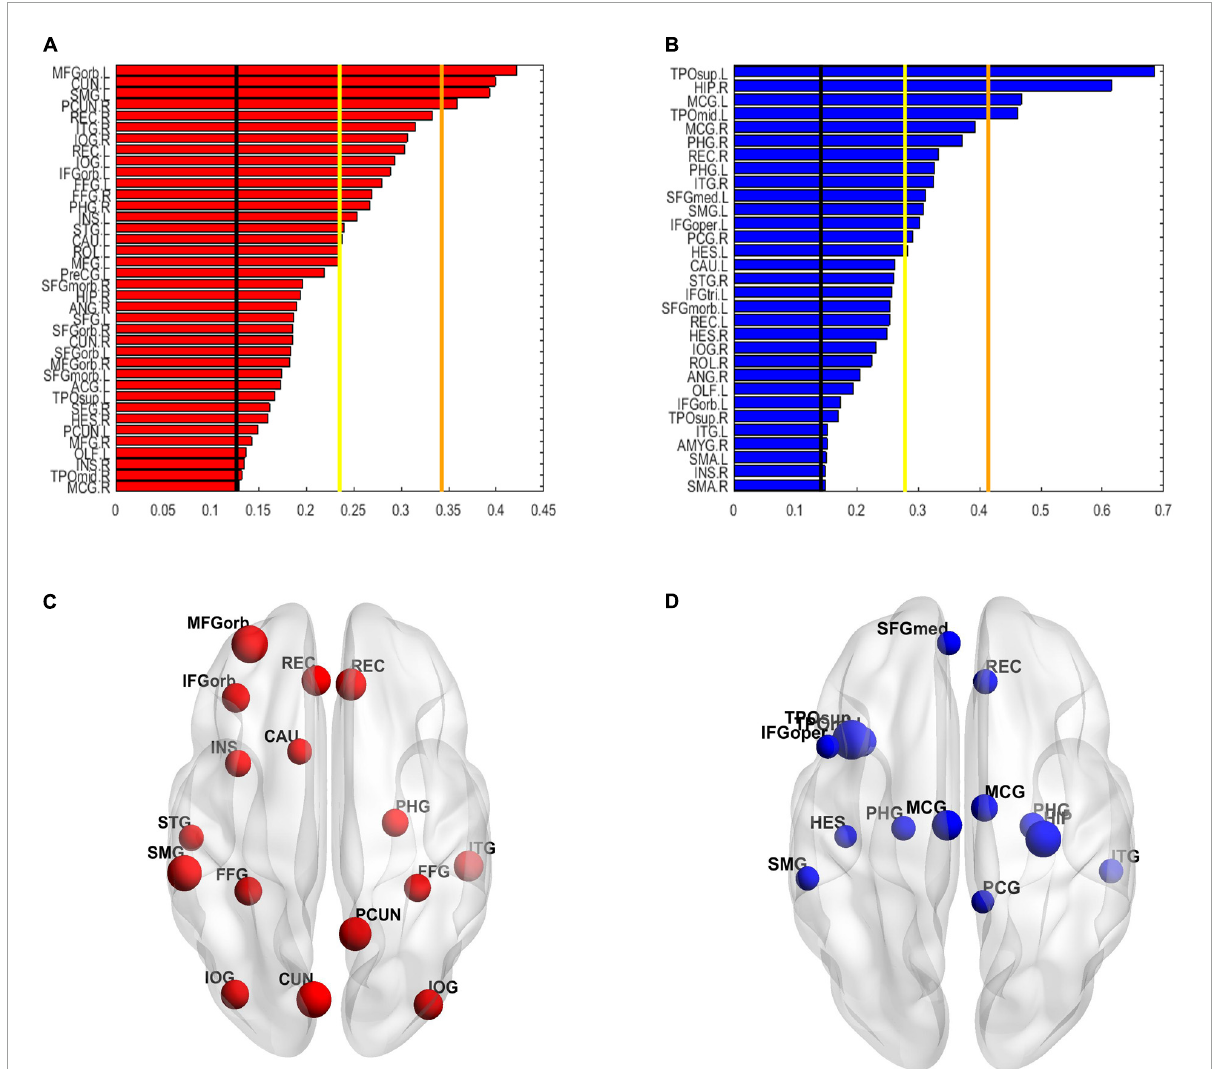
FIGURE3 The weighted degree maps of brain regions. (A,C) The brain regions with positive weighted degrees greater than mean + SD. (B,D) The brain regions with negative weighted degrees less than mean-SD. The black line, yellow line, and orange line indicate the mean value, mean ± – SD, and mean ± – 2SD, respectively. SD, standard